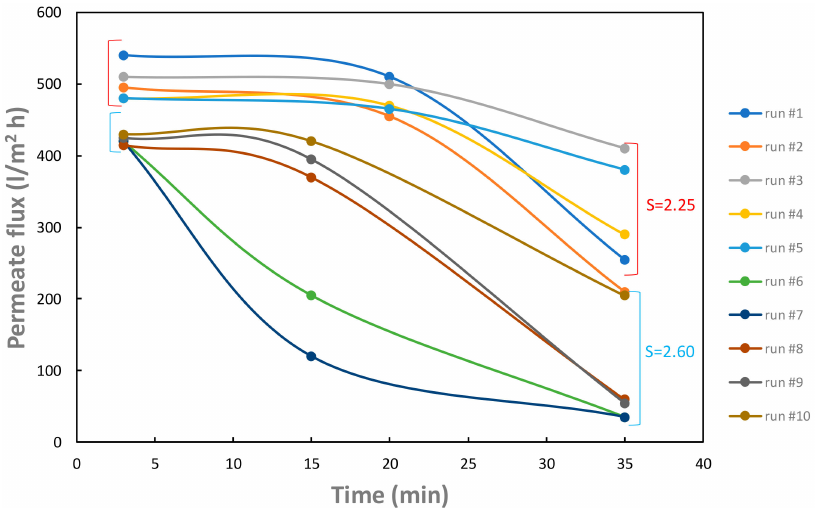
Figure 6. Membrane permeate fluxes as a function of citric acid for two supersaturation values.